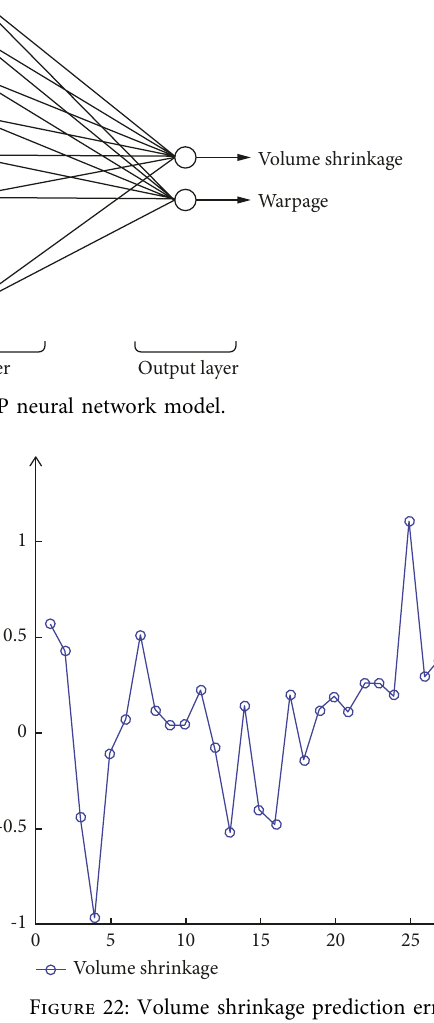
Figure 20: Figure of predicted results of volume shrinkage.